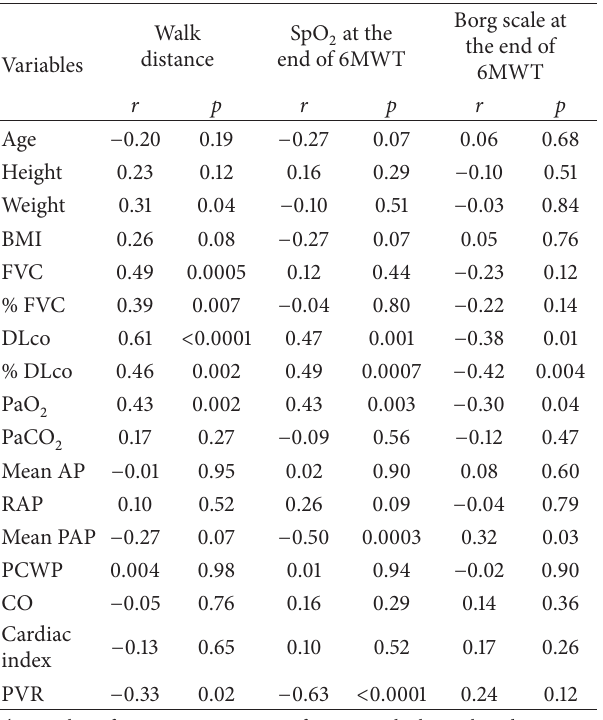
Table 3: Pearson correlation coefficients between 6 min walk test outcomes and various parameters.